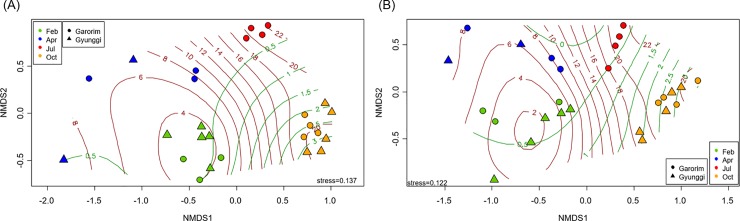
NMDS ordination of archaeal (A) and bacterial (B) communities with Bray-Curtis distance. Contour lines show a smooth generalized addictive model (GAM) surface reflecting best fitting environmental factors (Deviance explained: A. temperature 98.6% and NO2- 88.4%, and B. temperature 96.8% and NO2- 89.4% with P < 0.001 for all parameters).